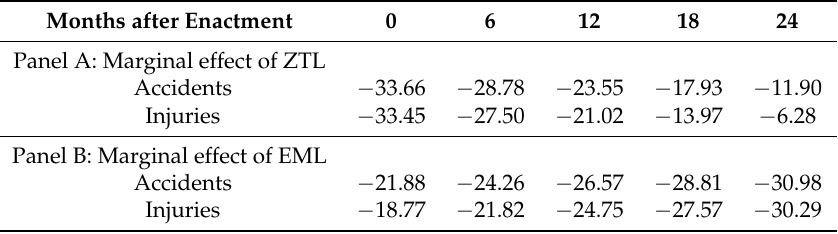
Table 3. Percentage Change in Accidents and Injuries over